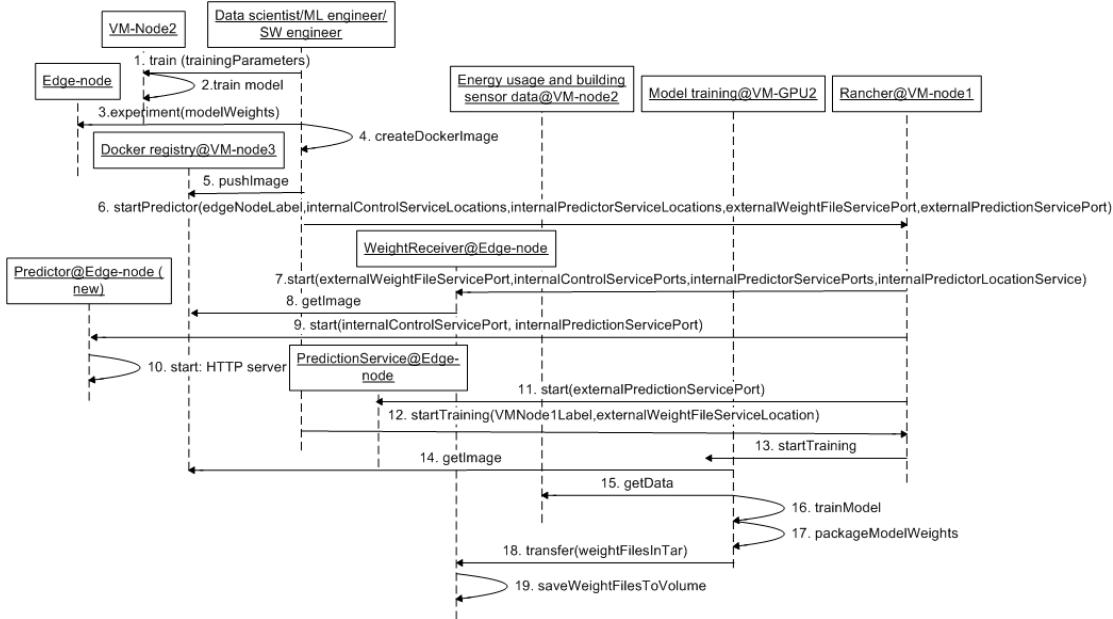
Figure 6. UML sequence view illustrating model training, packaging, and transferring to the edge-node.